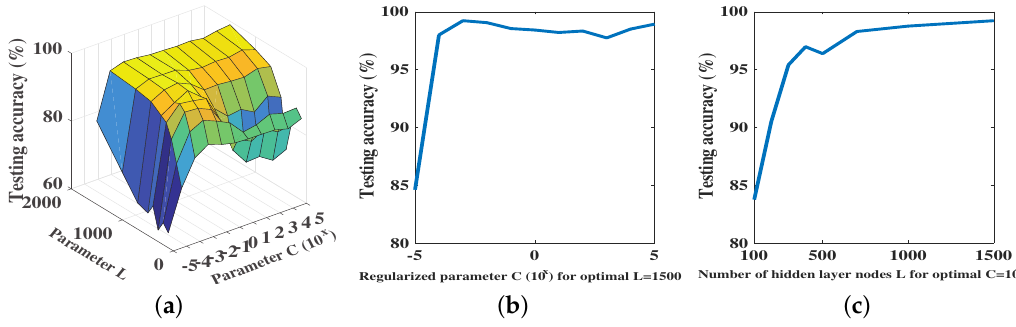
Figure 7. ( a ) Performance of the RRNN across the search space; ( b ) Performance of RRNN for the optimal L value; ( c ) Performance of RRNN for the optimal C